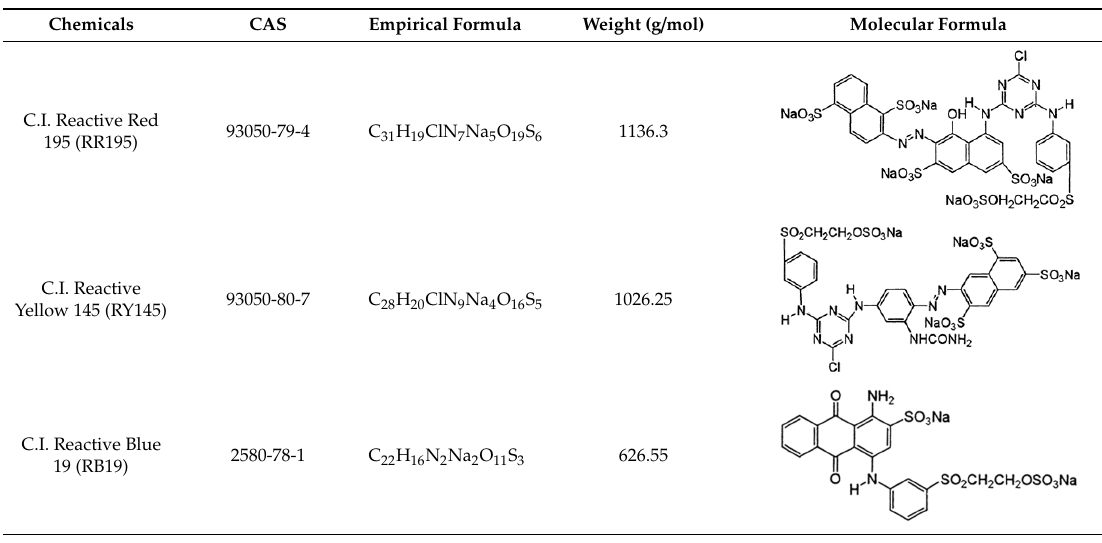
Table 1. Empirical and molecular formulae of the reactive dyes.